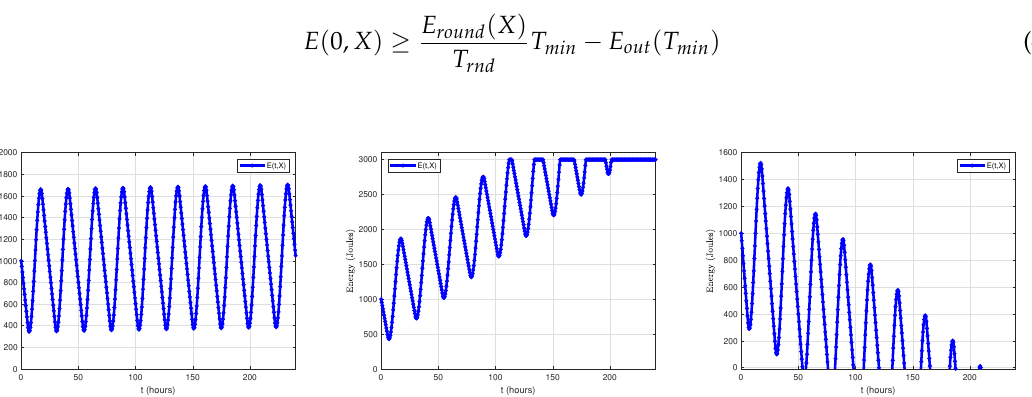
Figure 20. Evolution of E ( t , X ) for DC = 46% ( left ), for DC = 40% ( center ) and for DC = 50% ( right